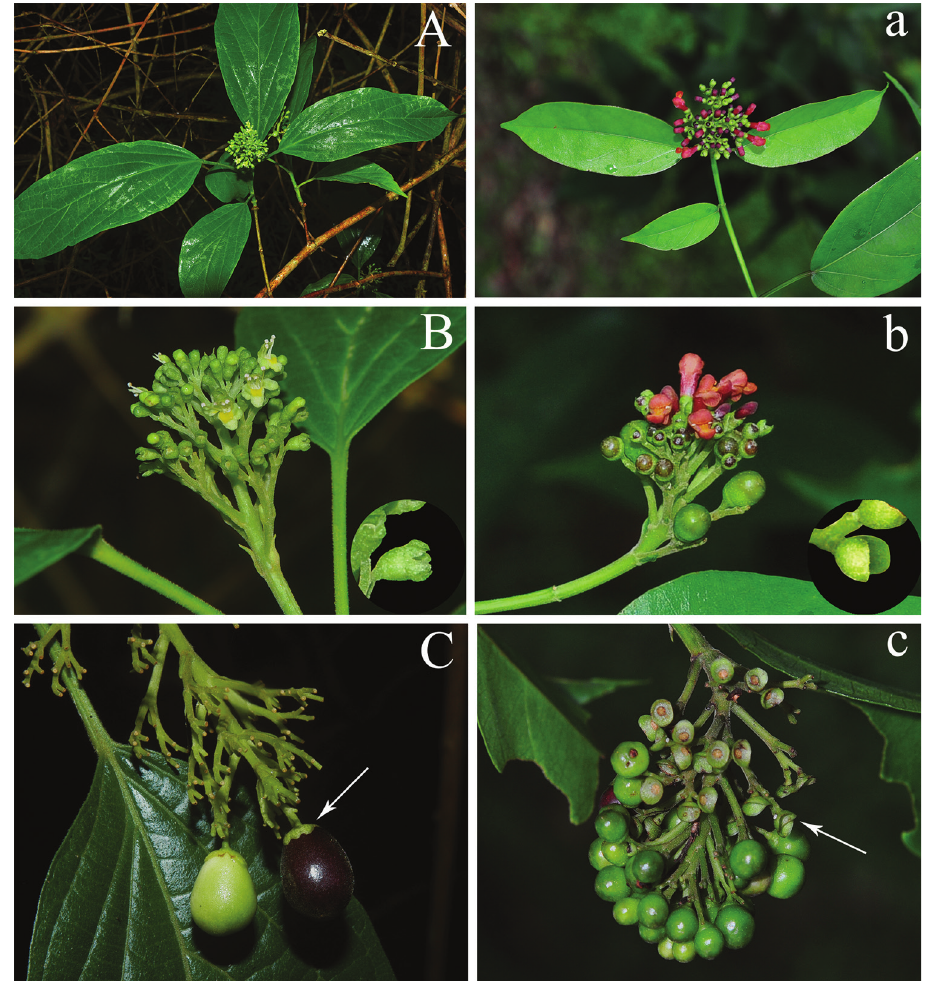
Figure 2. Morphological comparison between Premna bhamoensis ( A–C ) and P. menglaensis ( a–c ). A, a branchlets with inflorescences B, b inflorescences, flowers and calyces (in the blank circle) C, c fruites- cences and fruits (arrow show fruiting